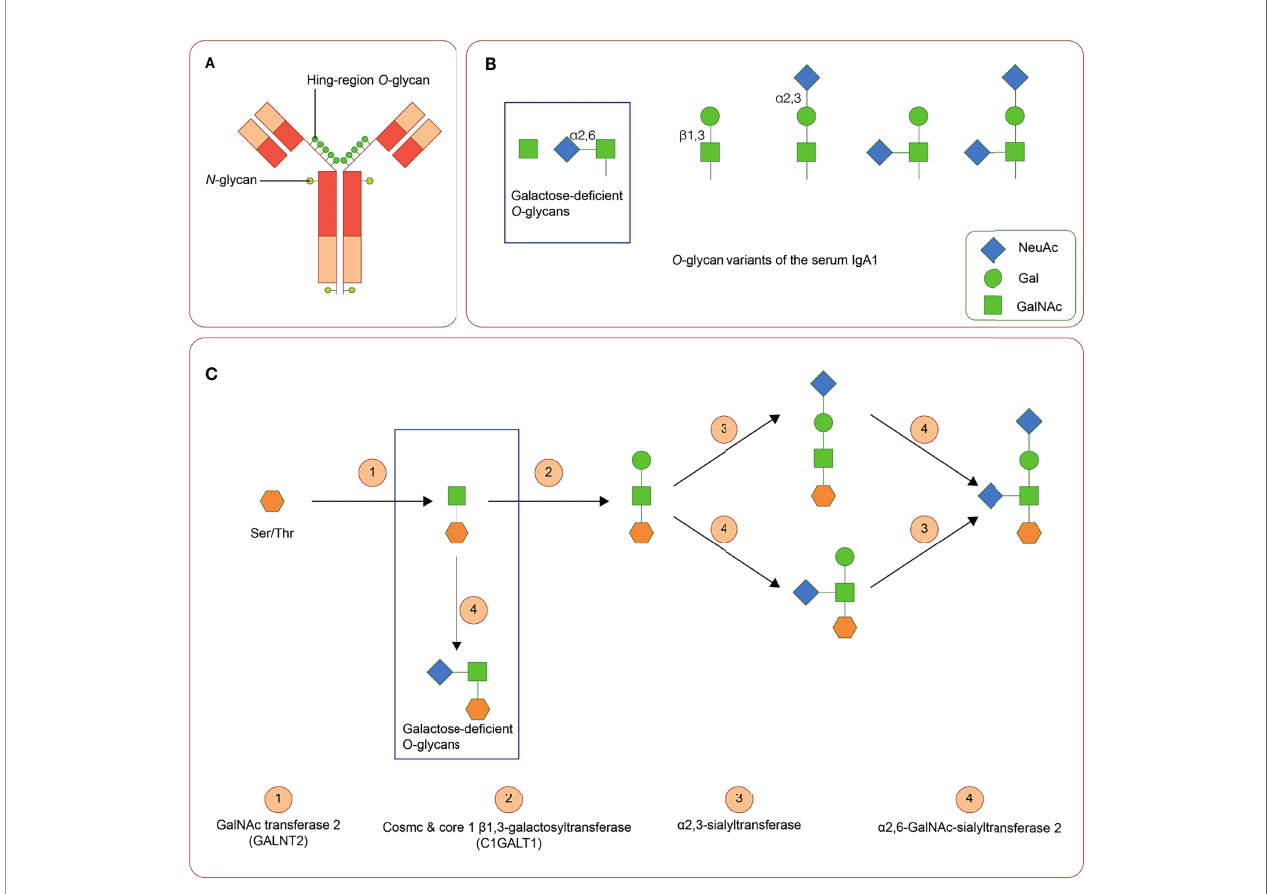
FIGURE 2 | IgA1 Oglycans (A) Structure of human IgA1. The hinge region of IgA1 usually contains three to six O-linked glycan sites. (B) Variants of IgA1 O-glycan. (C) Synthesis of human IgA1 O-glycans. Upregulated a -N-acetylgalactosaminide a 2,6-sialyltransferase 2 and down regulated core 1 b 1,3-galactosyltransferase (and Cosmc) can lead to the increase of galactose-de fi cient